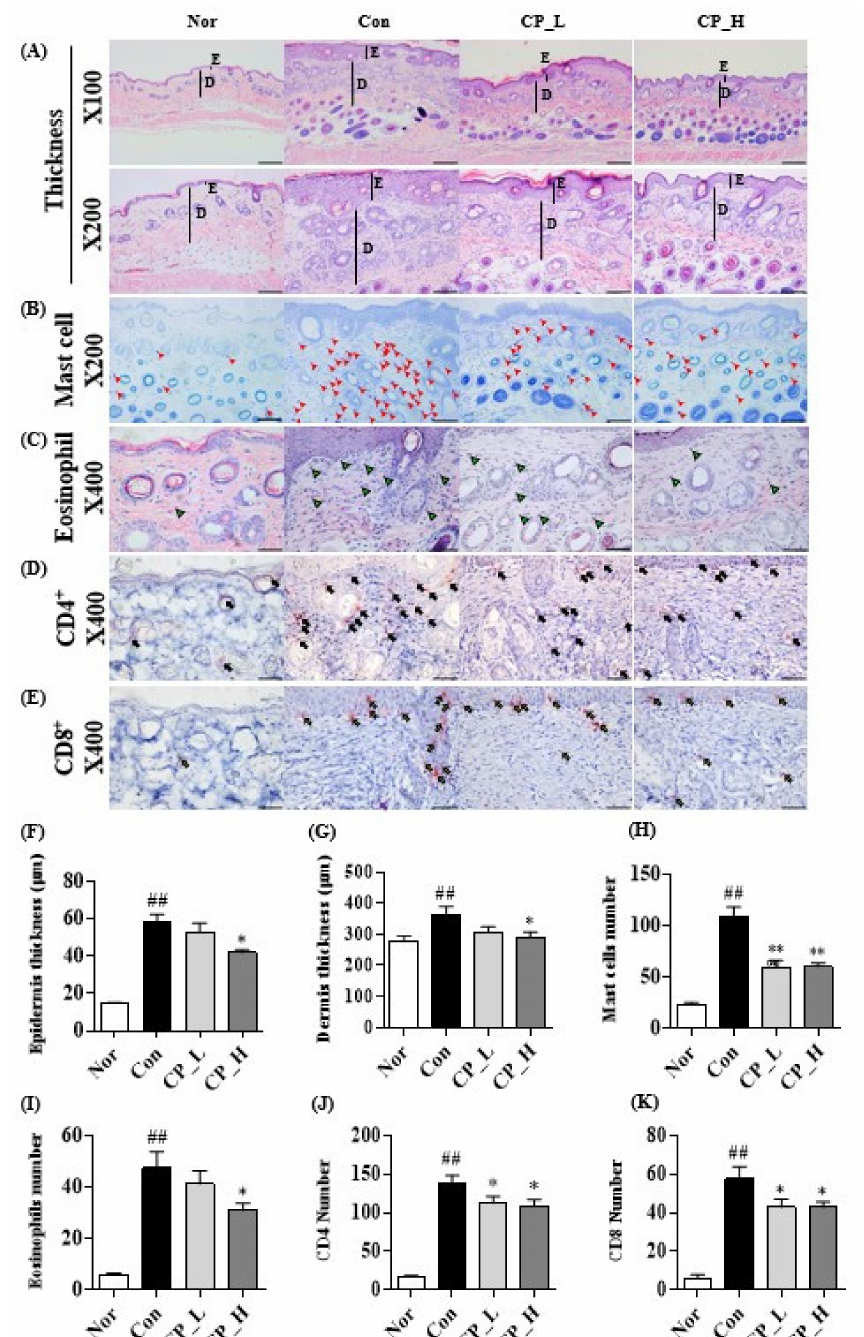
Figure 6. Effect of CP on immunohistochemical (IHC) and histological staining of DNCB-induced ACD-like skin lesions in mice. ( A , E – G ) Epidermal and dermal thickness were assessed via H&E staining ( × 100, scale bar 200 µ m; × 200, scale bar 100 µ m). ( B , H ) Mast cells (red arrow heads) were measured by toluidine blue staining ( × 200, scale bar, 100 µ m). ( C , I ) Eosinophils (green arrow heads) were counted after hematoxylin and eosin staining ( × 400, scale bar 50 µ m). ( D , J ) Infiltration of CD4 + T cells (black arrows) was examined by IHC staining of skin tissue sections ( × 400, scale bar 50 µ m). ( E , K ) Infiltration of CD8 + T cells (yellow arrows) was examined by IHC staining of the skin tissue sections ( × 400, scale bar 50 µ m). All data represent the means ± SEM ( ## p < 0.01 vs. Nor group. * p < 0.05 and ** p < 0.01 vs. Con